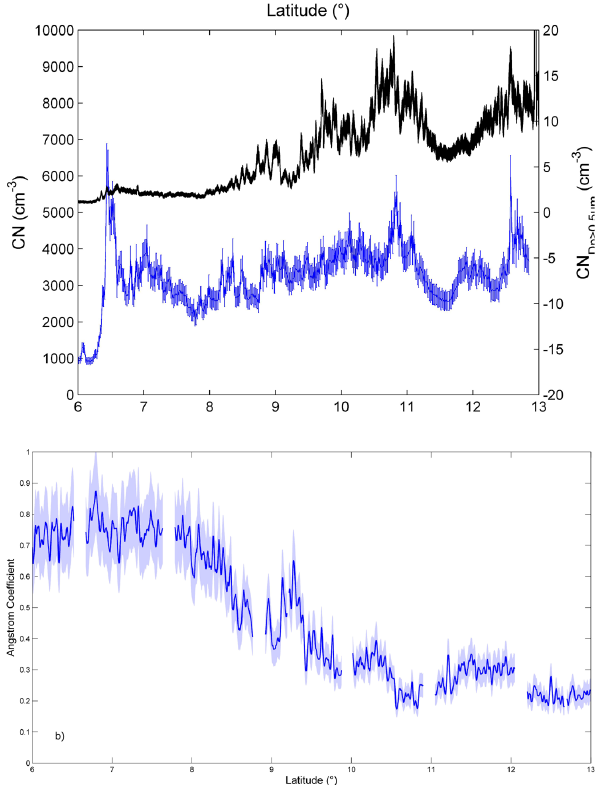
Fig. 8. (a) Total particle concentration (blue line) measured on- board the ATR-42 on 13 June between 10:30UTC and 13:30UTC as a function of latitude. Concentration of particles with diame- ter larger than 0.5µm is also plotted (in grey) as a function of lati- tude. The red rectangle denotes the zone where the dust content is maximum. (b) The Angstrom coefficient calculated from scattering coefficients is represented by the blue line. The light blue area cor- responds to the error bar including uncertainty in the measurements of scattering coefficients and propagation of errors during calcula- tions.